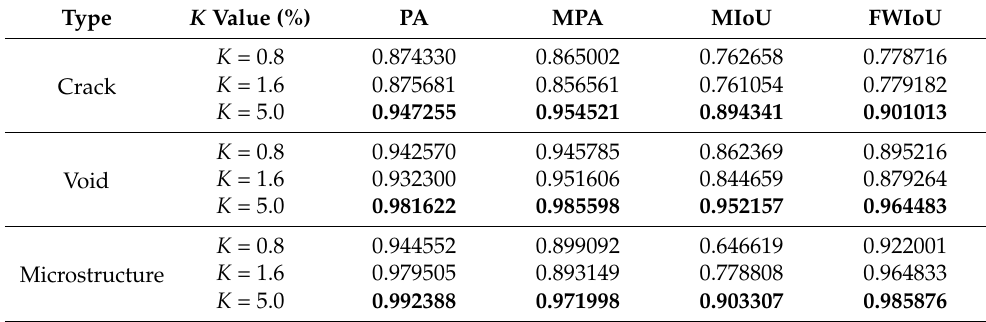
Figure 11. The identification of fatigue cracks, voids, and carbides in the turbine blades with the OISM. ( a – c ) are the images of crack, voids, and microstructure; ( 1 ) and ( 2 ) are the original images and the segmentation target mask of the fatigue test. Table 3. Evaluation indexes of the image segmentation in different turbine blades with the OISM .